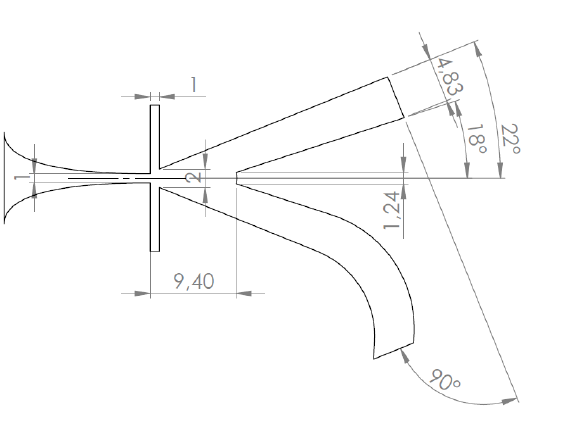
Figure 1. The bistable fluidic amplifier used in the design of the transducer with dimensions in